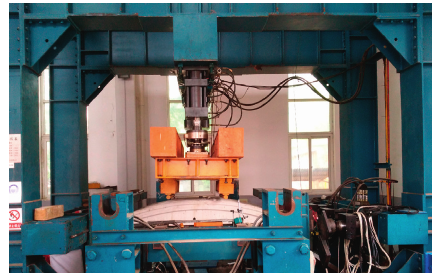
Figure 2: Loading system of the full-scale experiment.